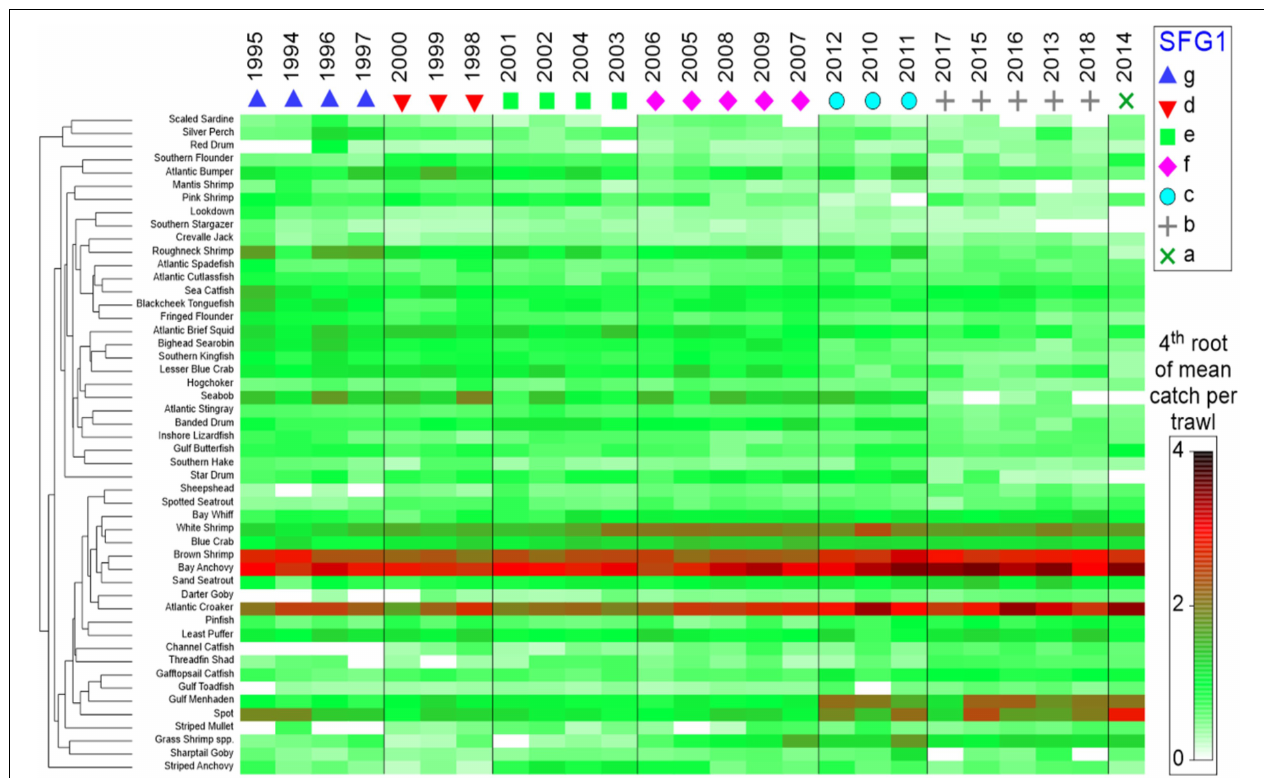
FIGURE 5 | Seriated heatmap of annual abundance data for species captured in trawl surveys conducted by the Louisiana Department of Wildlife and Fisheries, 1994–2018. Similarity Profile Analysis (SIMPROF) was applied to Bray-Curtis hierarchical year clusters (group average method), with significant SIMPROF groups (SFG1) arranged in columns. Shading is the 4th root of the relative abundance indices (mean numbers per trawl tow) by species. Species that were absent in five or more years were